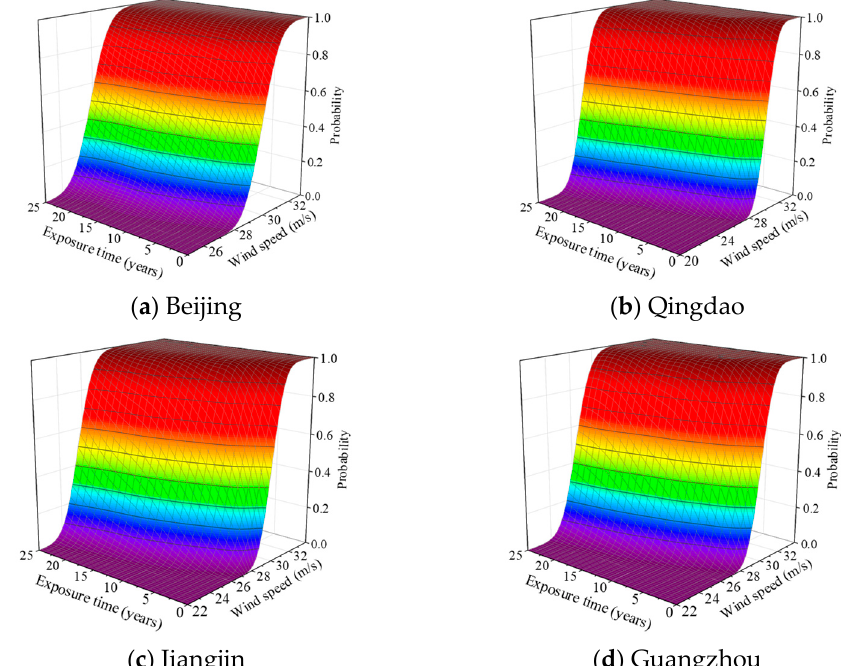
Figure 19. Fragility surface of the collapsed basic wind speed in each region.